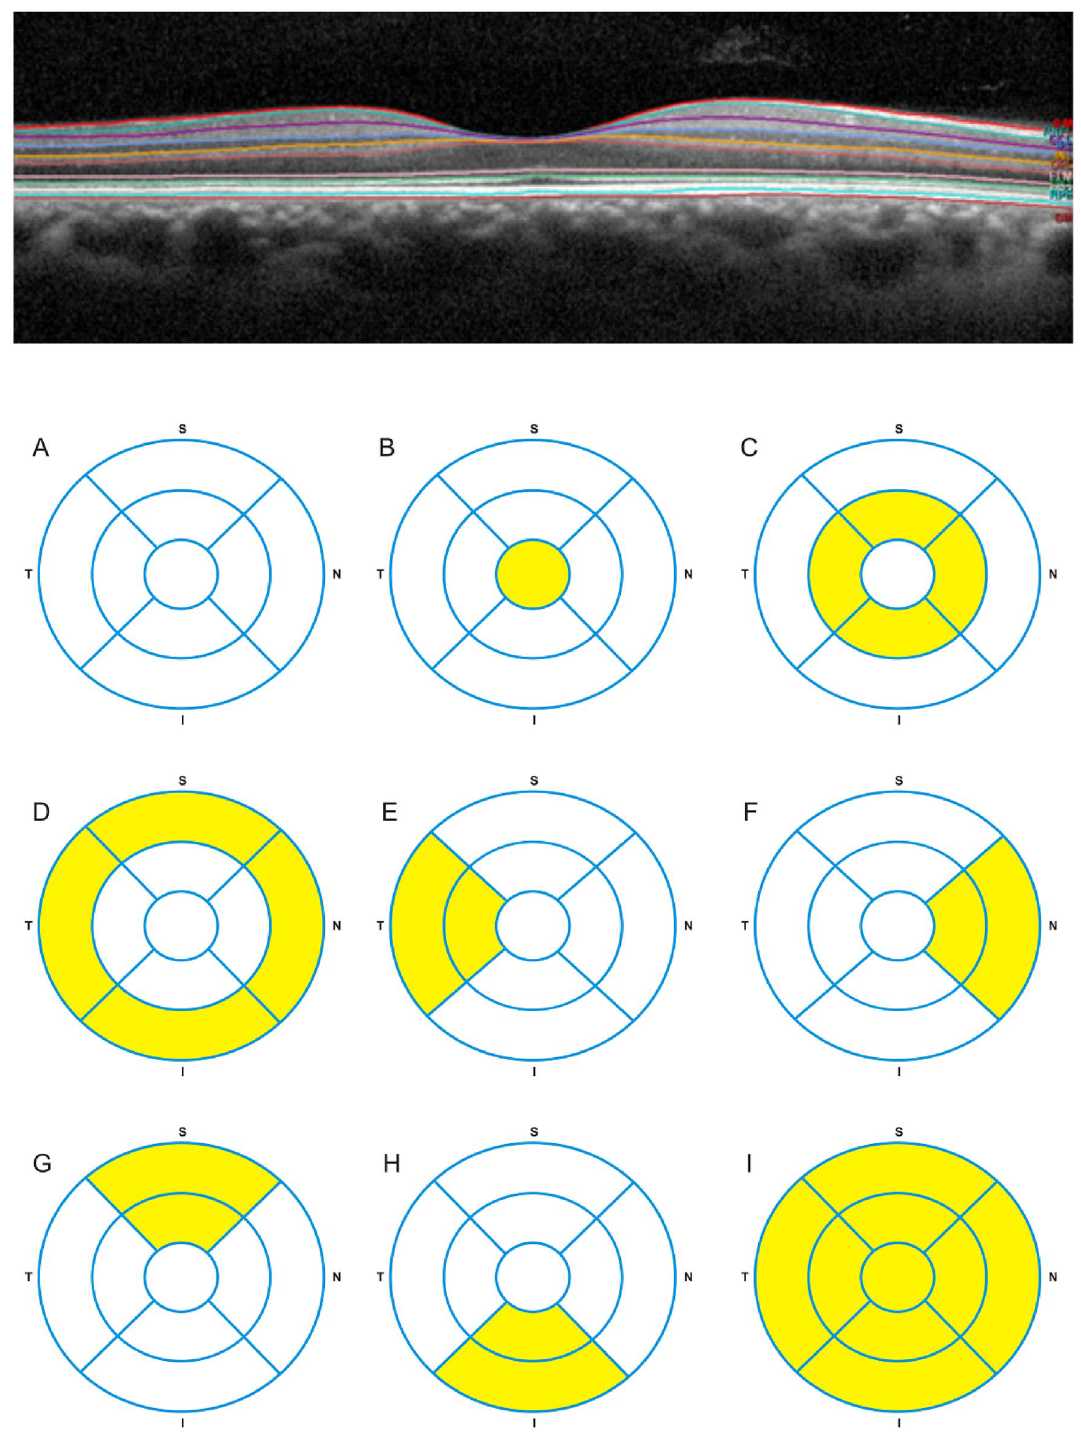
Figure 3. Retinal layers were identified by automatic segmentation in SD-OCT—retinal nerve fibre layer (RNFL), ganglion cell layer (GCL), inner plexiform layer (IPL), inner nuclear layer (INL), outer plexiform layer (OPL), outer nuclear layer (ONL) and outer retinal layer (ORL)—between the external limiting membrane and the bruch membrane (top panel). The mean thickness of each individual retinal layer was analysed in: (1) the nine individual ETDRS subfields ( A ); the fovea (or central circle with a diameter of 1 mm) ( B ); the inner ring ETDRS subfields ( C ); the outer ring ETDRS subfields ( D ); and globally ( I ). For RNFL and GCL the mean layer thicknesses of the outer and inner temporal ( E ), nasal ( F ), superior ( G ) and inferior ( H ) (bottom panel). Bottom panel adapted from Won et al. 32